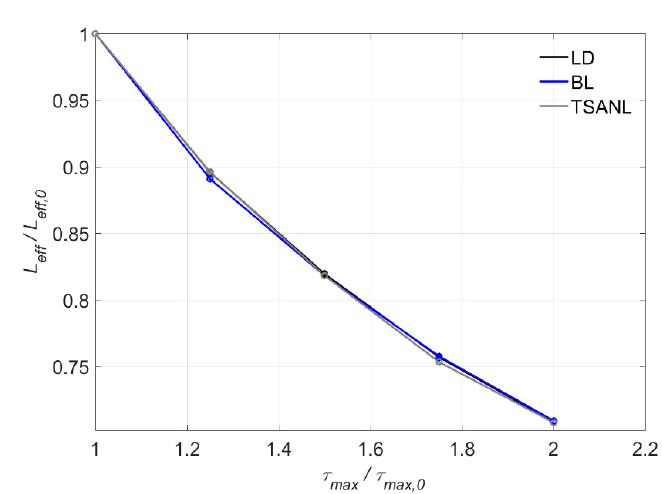
Figure 16. Variation of L eff versus τ max .